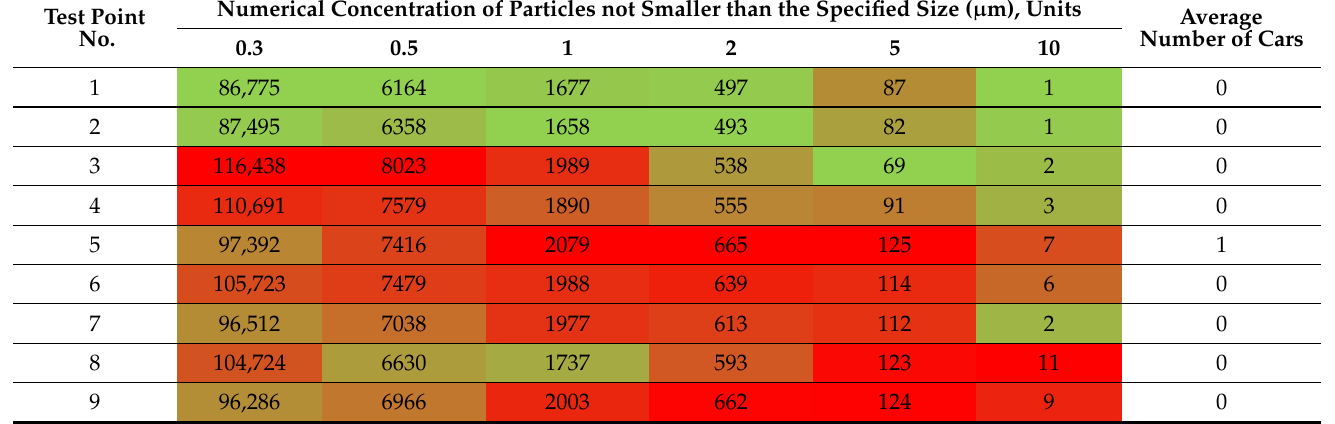
Table 5. Mean numerical concentrations of particulate matter at a height of 1.5 m in zone B. Test Point